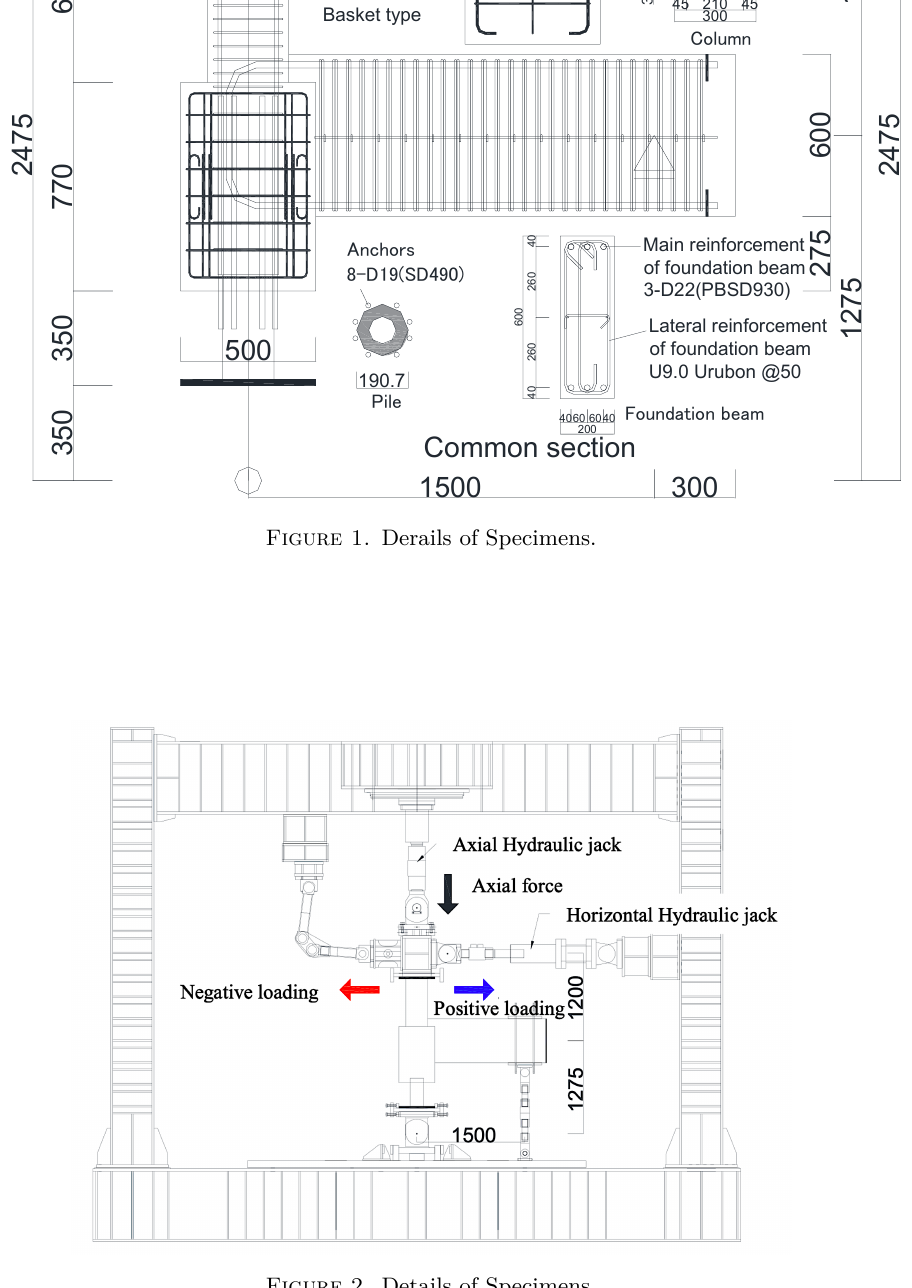
Figure 2. Details of